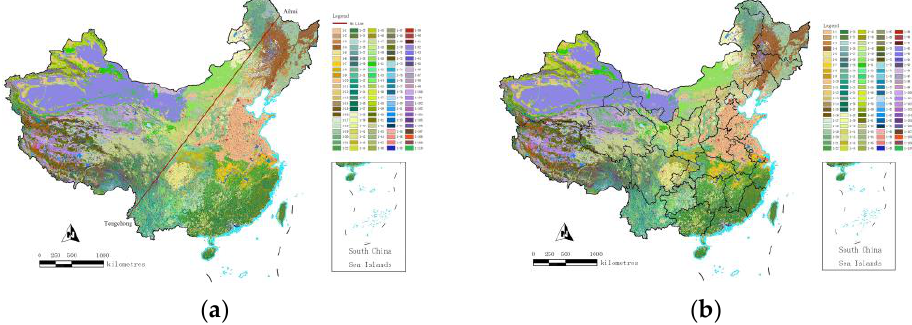
Figure 7. Landscape character types (LCTs) maps superimposed on ( a ) Hu Line and the ( b ) and administrative boundaries of China.